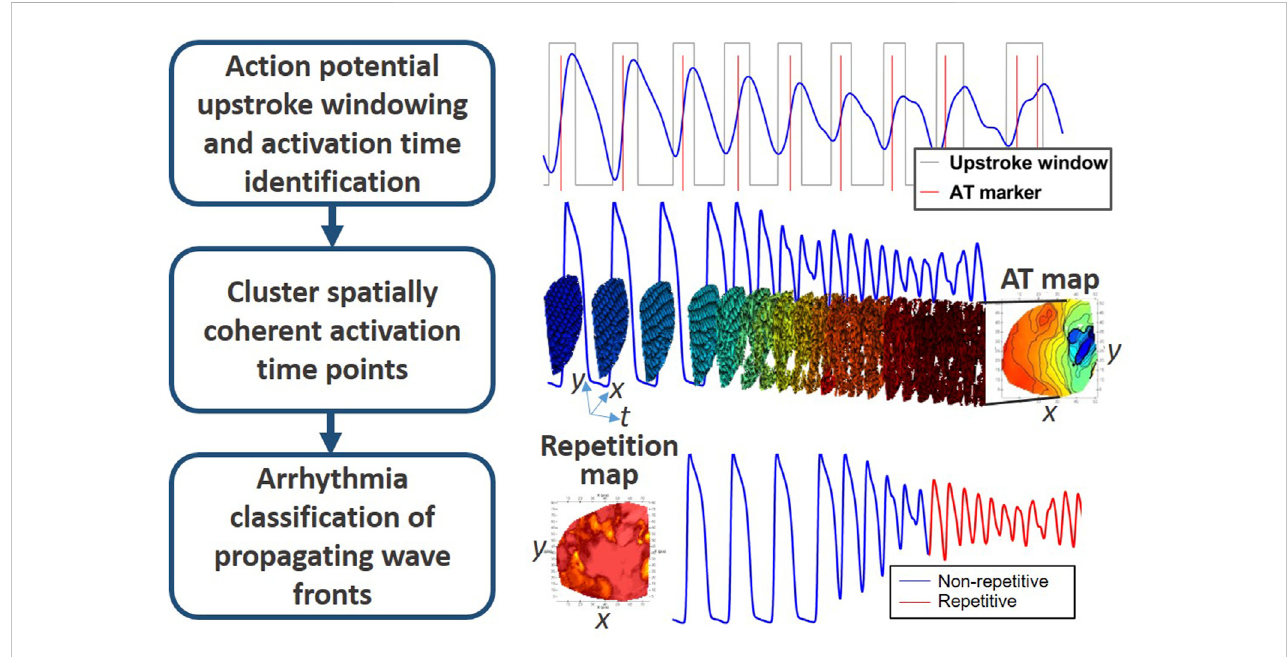
FIGURE 2 Schematic work fl ow of the novel pAT mapping